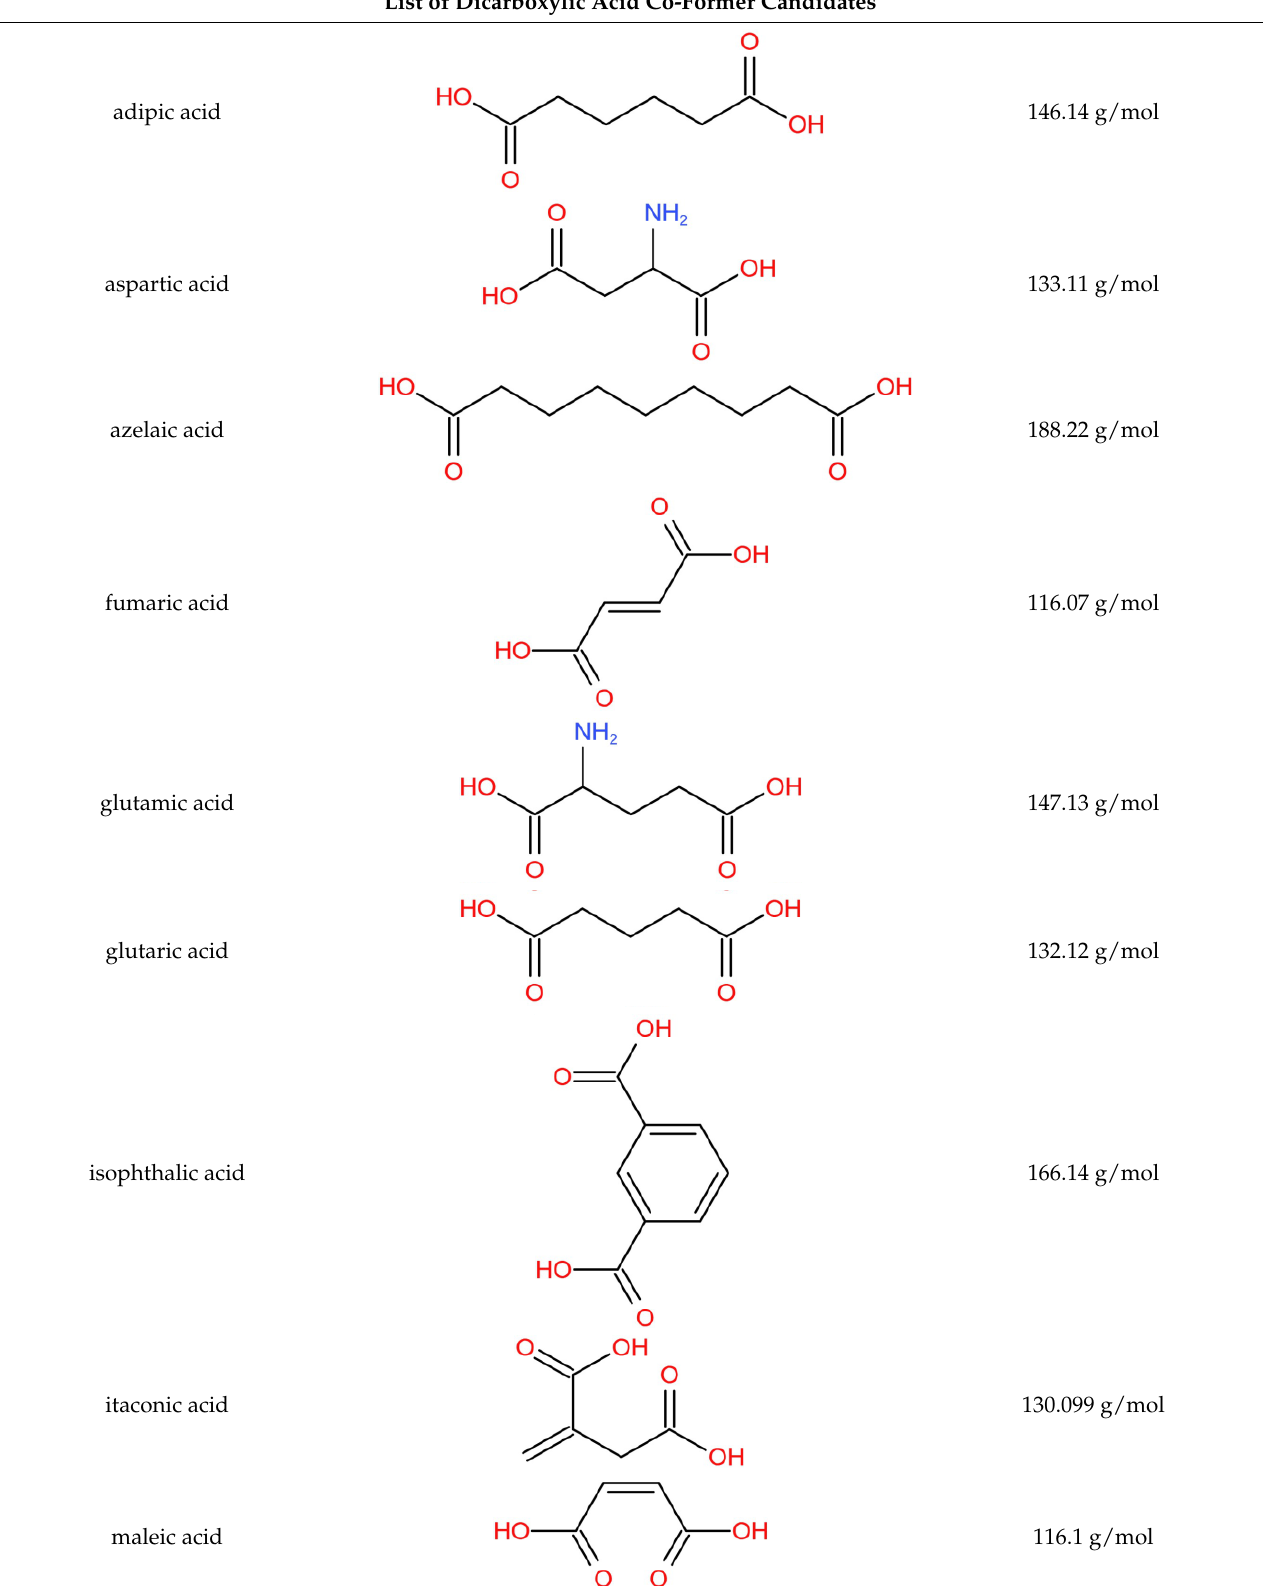
Table 1. List of co-former candidates.